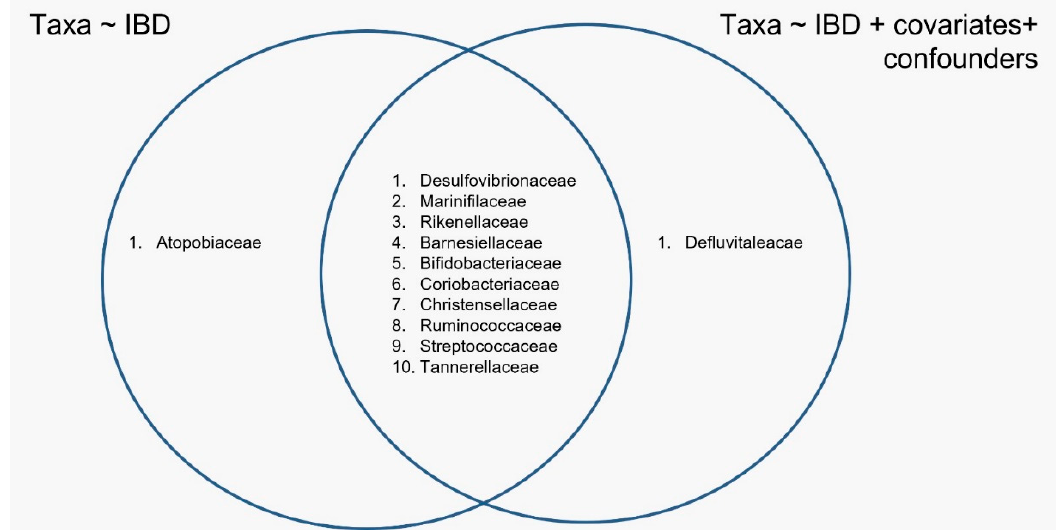
Figure 1. Differentially abundant bacterial families in samples from the CD (cyan) and UC patients (green) compared with the HC (pink), as detected using a GLM model only considering the IBD status (A) or using a GLM considering the IBD status and covariates and confounders (B). The rel- ative abundance is plotted in log10 on the y -axis.